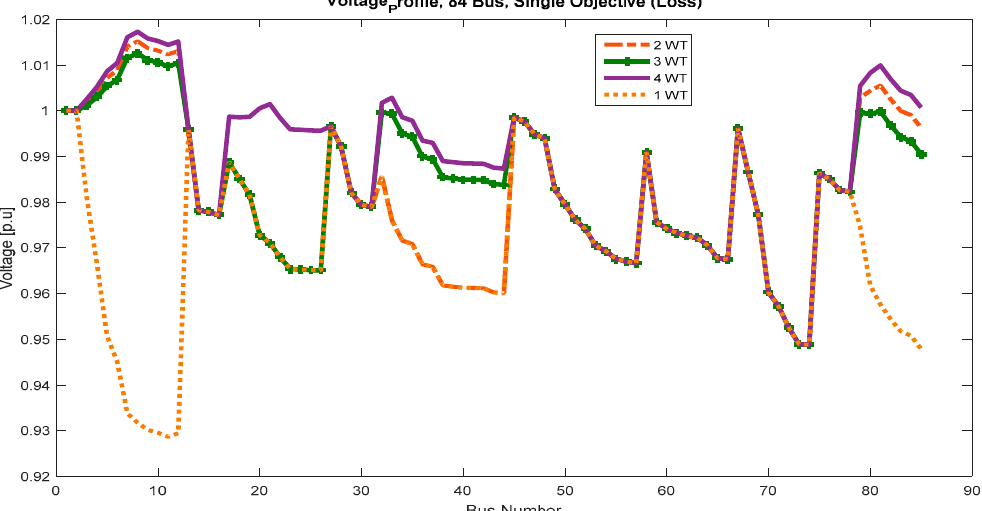
Figure 4. This Convergence 84-bus grid voltage profile with and without using WTs without regard to constraints (single-objective).